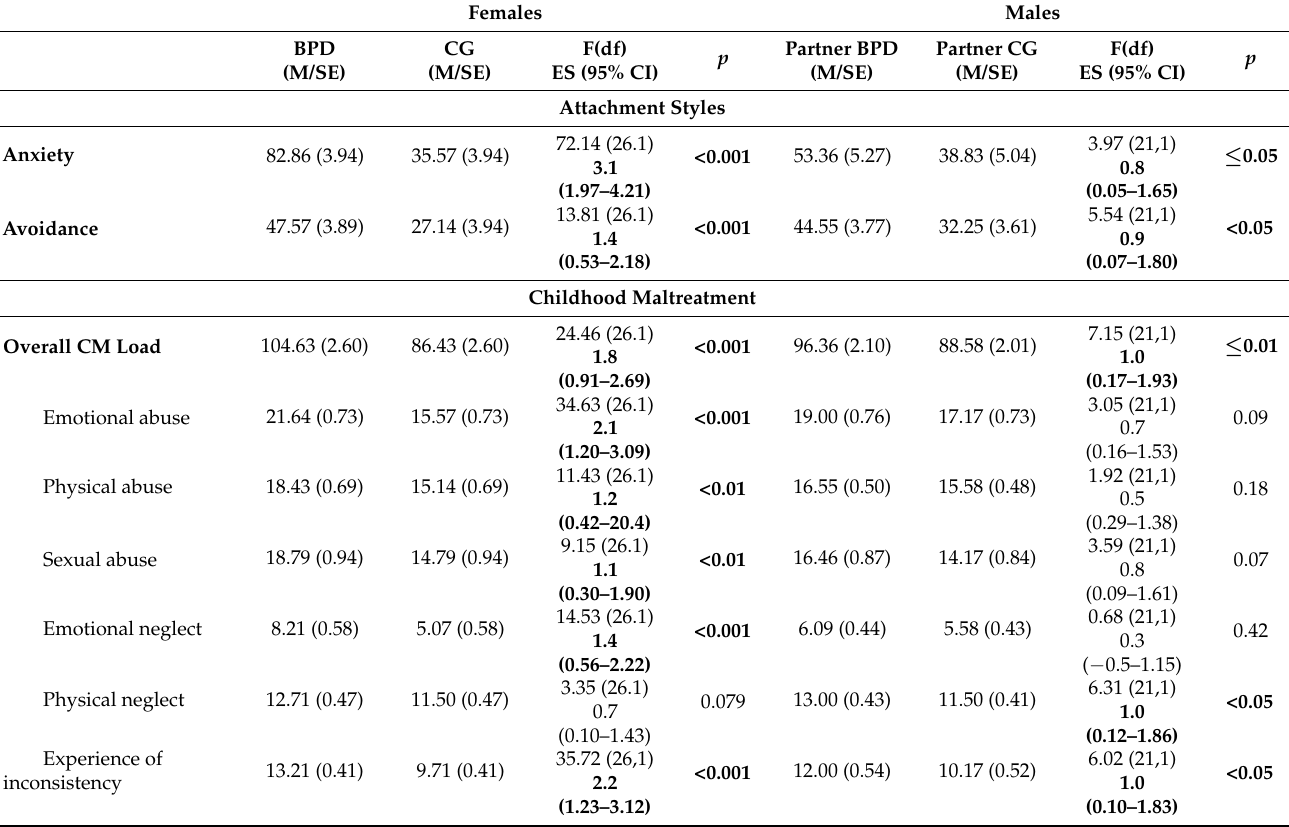
Table 3. Attachment, Trauma, Personality: Marginal Means, Significance, and Effect Size.